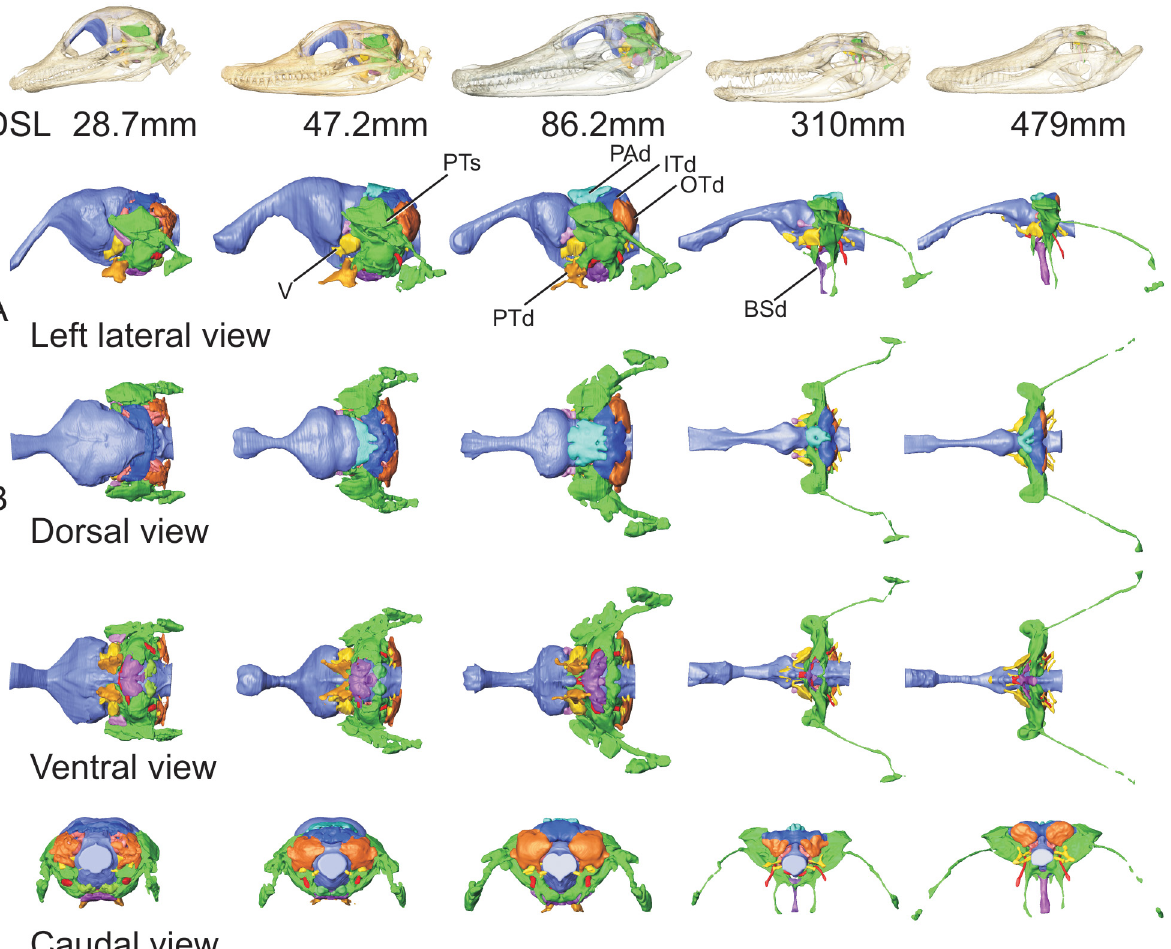
Fig 13. Ontogenetic series of Alligator mississippiensis showing the skulls rendered transparent, the brain endocast in blue, and the middle ear sinuses and component diverticula in various other colors. Columns pertain to different views of the same specimen. Specimens illustrated at unit scale to emphasize changing relative sizes of components. Rows: A) left lateral view; B) dorsal view; C) ventral view; D) caudal view. BSd , basisphenoid diverticulum; ITd , intertympanic diverticulum; OTd , otoccipital diverticulum; PAd , parietal diverticulum; PTd , pterygoid diverticulum; V , trigeminal nerve.